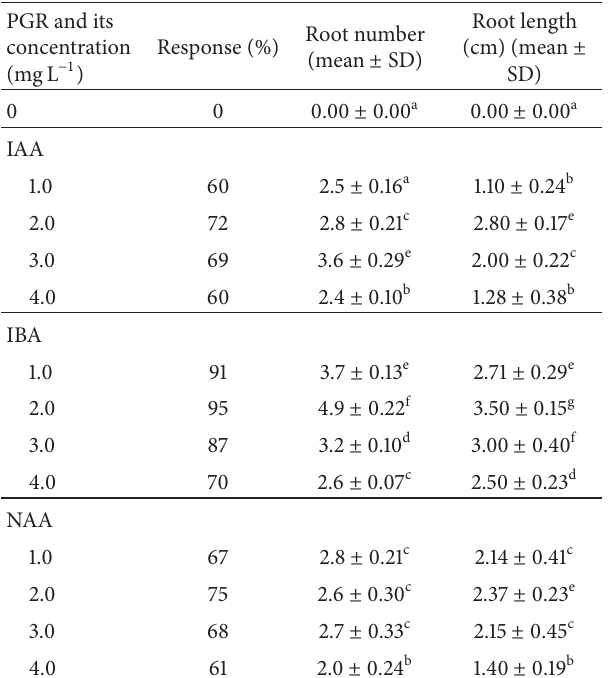
Table 4: Effect of auxins on in vitro root induction of R. pectinata on half strength MS